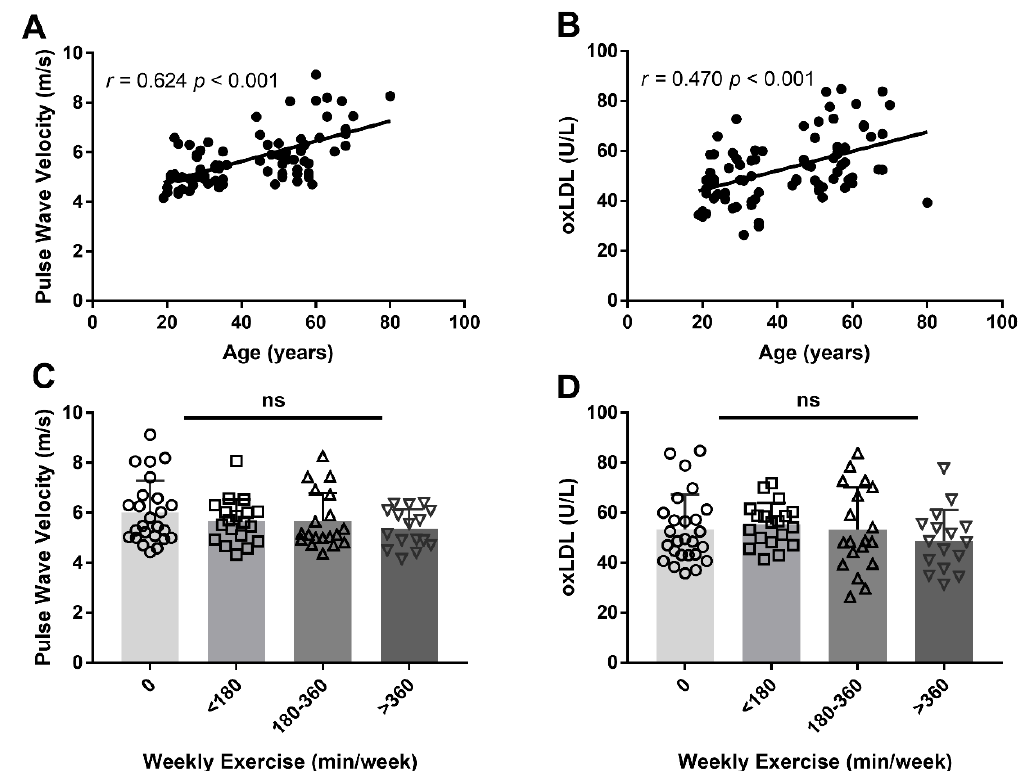
Figure 1. Pearson’s correlation between age with pulse wave velocity (PWV) ( A ), as a surrogate marker for arterial sti ff ness, and oxidised low-density lipoprotein (oxLDL) concentrations ( B ). One-way analysis of variance was conducted for PWV ( C ) and oxLDL concentrations ( D ) between weekly exercise duration, stratified across four groups. Each symbol represents an individual that participated in 0 min (circle), < 180 min (square), 180–360 min (upward triangle) and > 360 min (downward triangle) of weekly exercise for the past five years. ns = not significant.